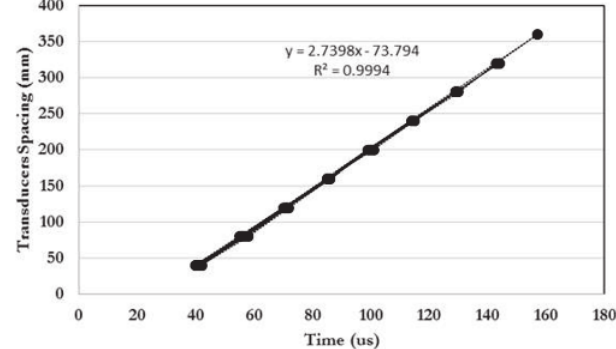
Shear wave velocity determination for the ultra-thin